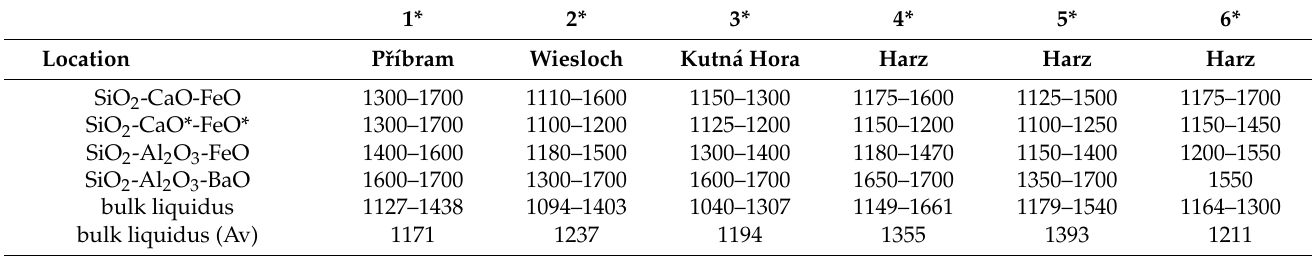
Table 8. Estimation of smelting temperatures ( ◦ C) for different European localities based on ternary diagrams and liquidus calculations. Av—average value, comparative data: 1*—Czech Republic